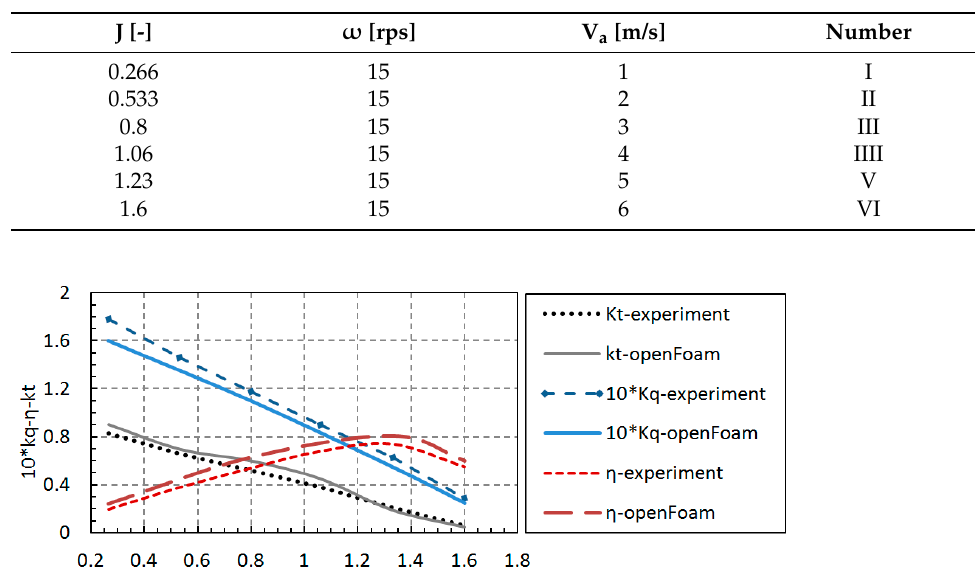
Table 5. Different advance coefficient specifications.